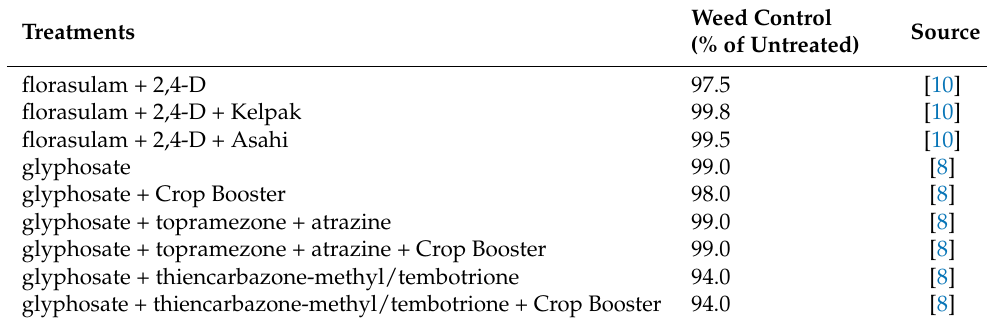
Table 1. Responses of Chenopodium album to the tank mixed application of herbicides and biostimu- lants (Kelpak, Asahi and Crop Booster) compared to the single herbicide